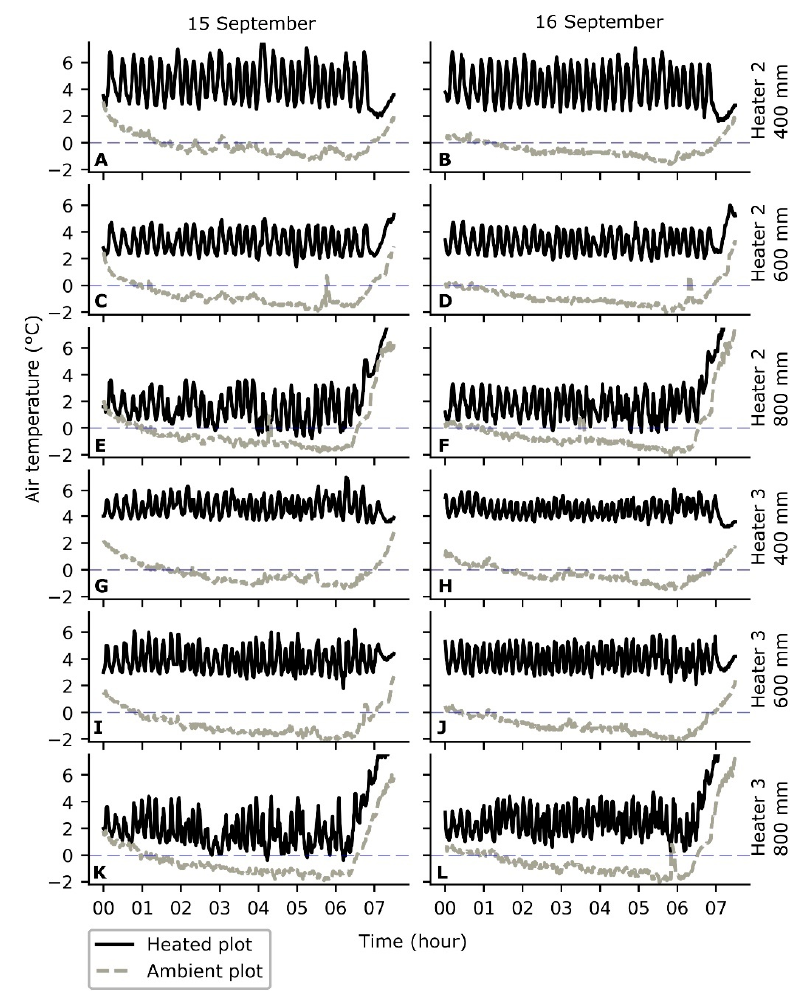
Figure 6. Air temperature record by T-Type thermocouples at 400, 600 and 800 mm AGL for the heated plot (solid line) and adjacent unheated plot (dashed line) on 15 September ( A , C , E , G , I , and K ) and 16 September 2018 ( B , D , F , H , J , and L ) for heaters number two ( A – F ) and three ( G – L ). Note heater 1 not deployed in 2018. The heaters kept air temperature between 2–7 ° C at 400 mm AGL, 1.5–6 ° C at 600 mm AGL and − 0.8–4.6 ° C at 800 mm AGL across the two consecutive frost events. Demonstrating that the heaters keep air temperature within the canopy (canopy height = 680 mm) > 0 ° C when air temperature in the unheated plots drops to − 2.2 ° C. The duration from the heater triggering to turning off was ~10 min for both heaters, across the two events.